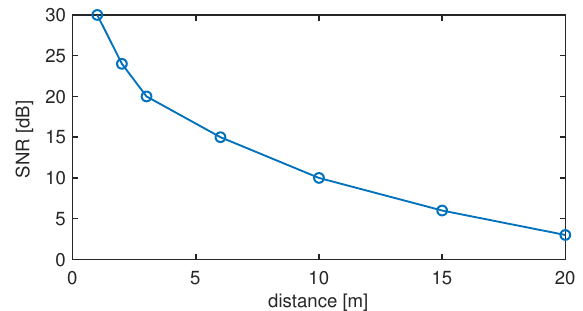
Figure 8. SNR as a function of the